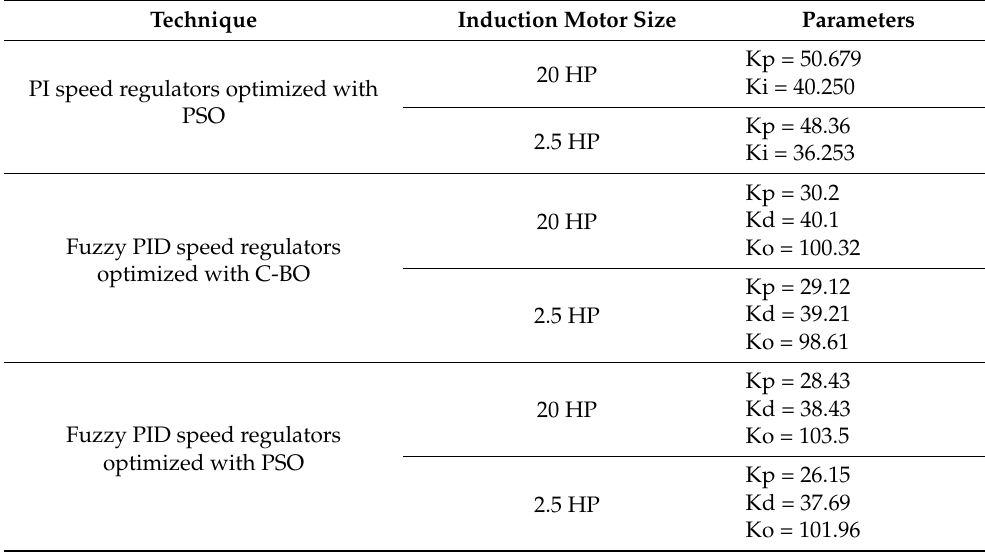
Table 6. Optimal parameters of the speed